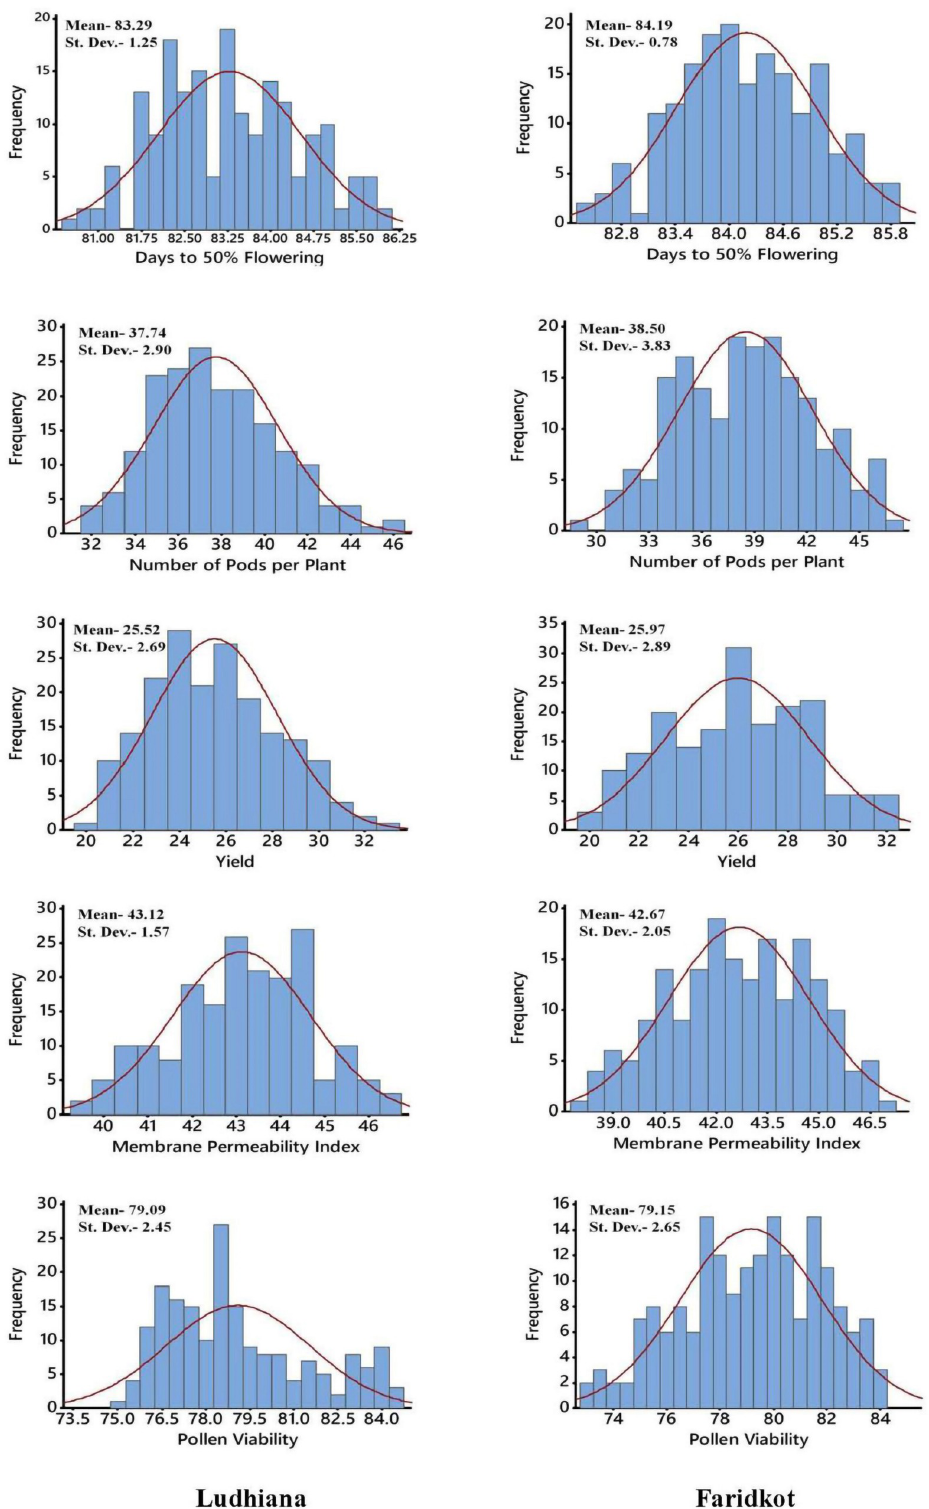
Fig 2. Graphical representations of RILs for the various traits in chickpea using pooled phenotypic data between timely-sown and late-sown condition at Ludhiana and Faridkot.